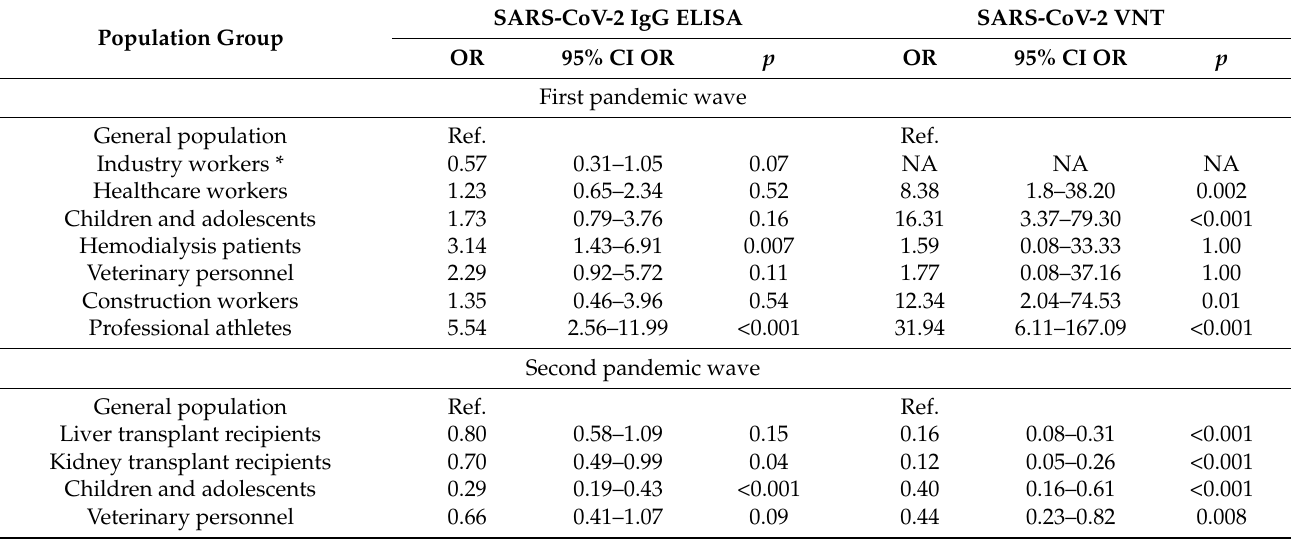
Table 2. Risk analysis for SARS-CoV-2